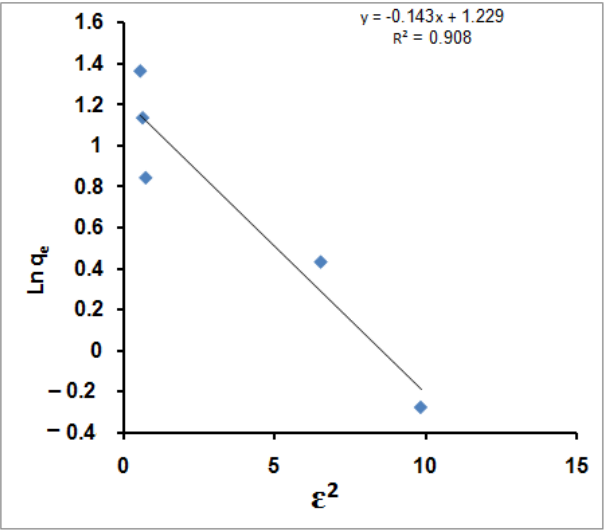
Figure 4. D-R isotherm for MB adsorption using SPGMA. The D-R plot yields a straight line with the R 2 value equal to 0.908, which indicates